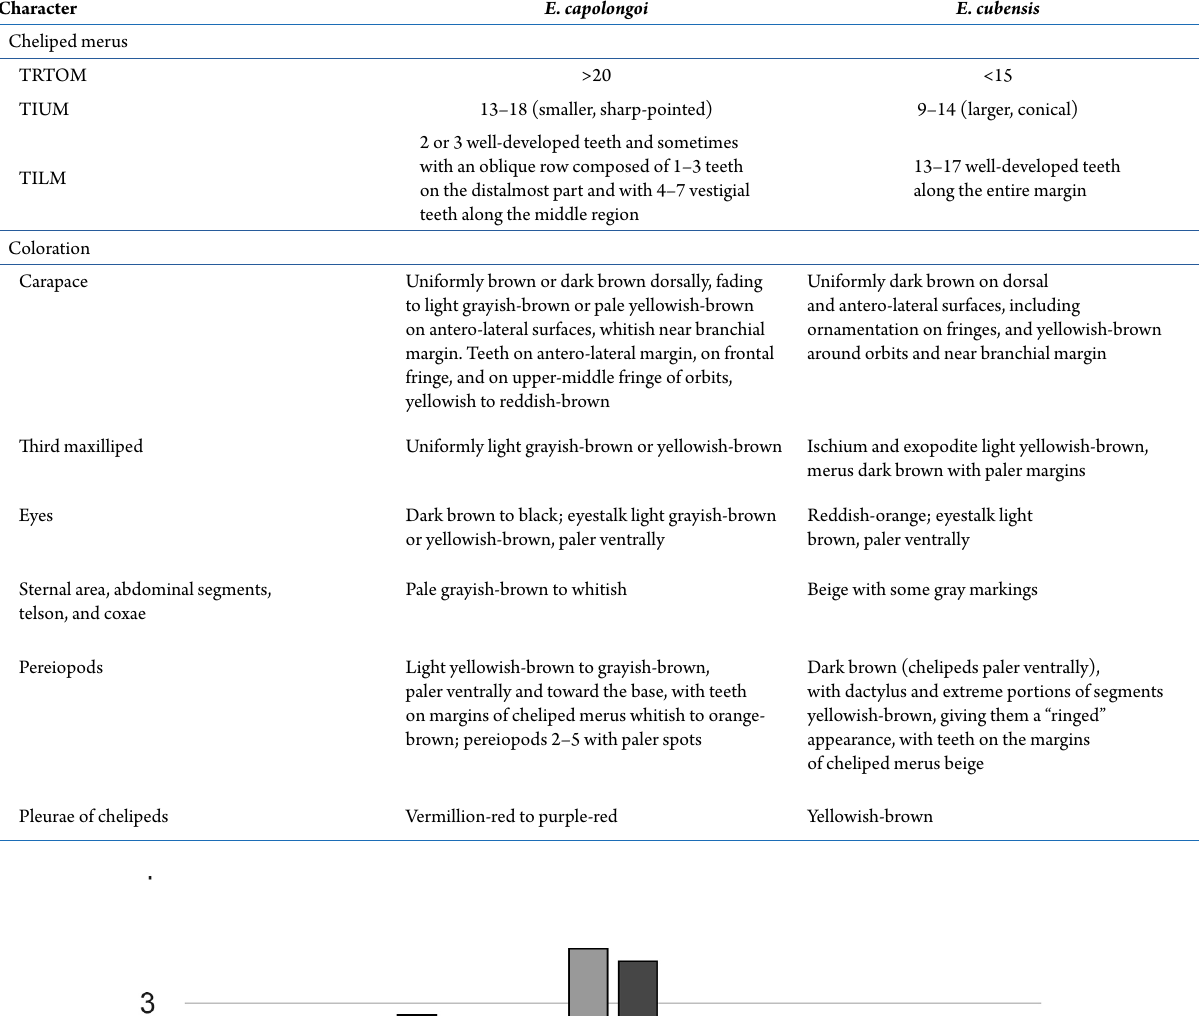
Table 1. Comparison of ornamentation on the cheliped merus and coloration in life between Epilobocera capolongoi and E. cubensis . Abbreviations: TRTOM (irregular transverse rows of tubercles on the outer margin), TIUM (teeth on the inner upper margin), TILM (teeth on the inner lower margin).